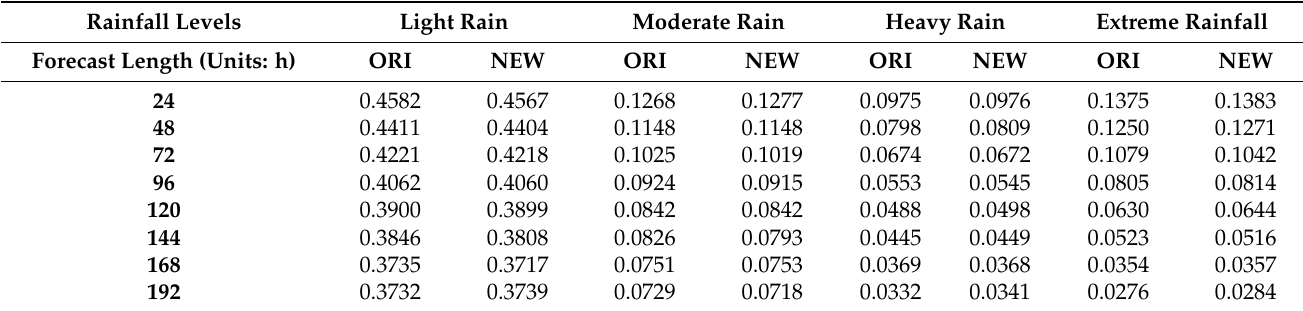
Table 5. TS of precipitation at different rainfall levels over East Asia.